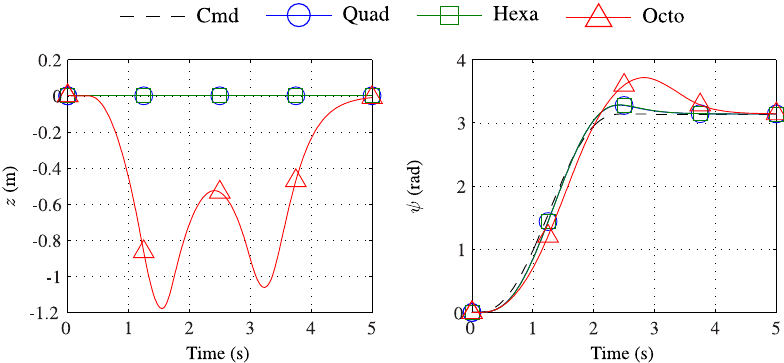
Figure 13. Dynamic response in yaw and height outputs for each multirotor when performing a fast yaw